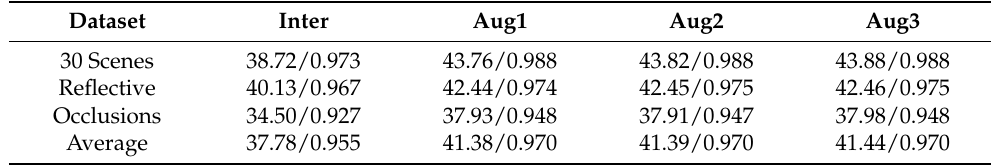
observe the best PSNR (dB) and SSIM values on task 2: 2 × 2 − 8 × 8 extrapolation